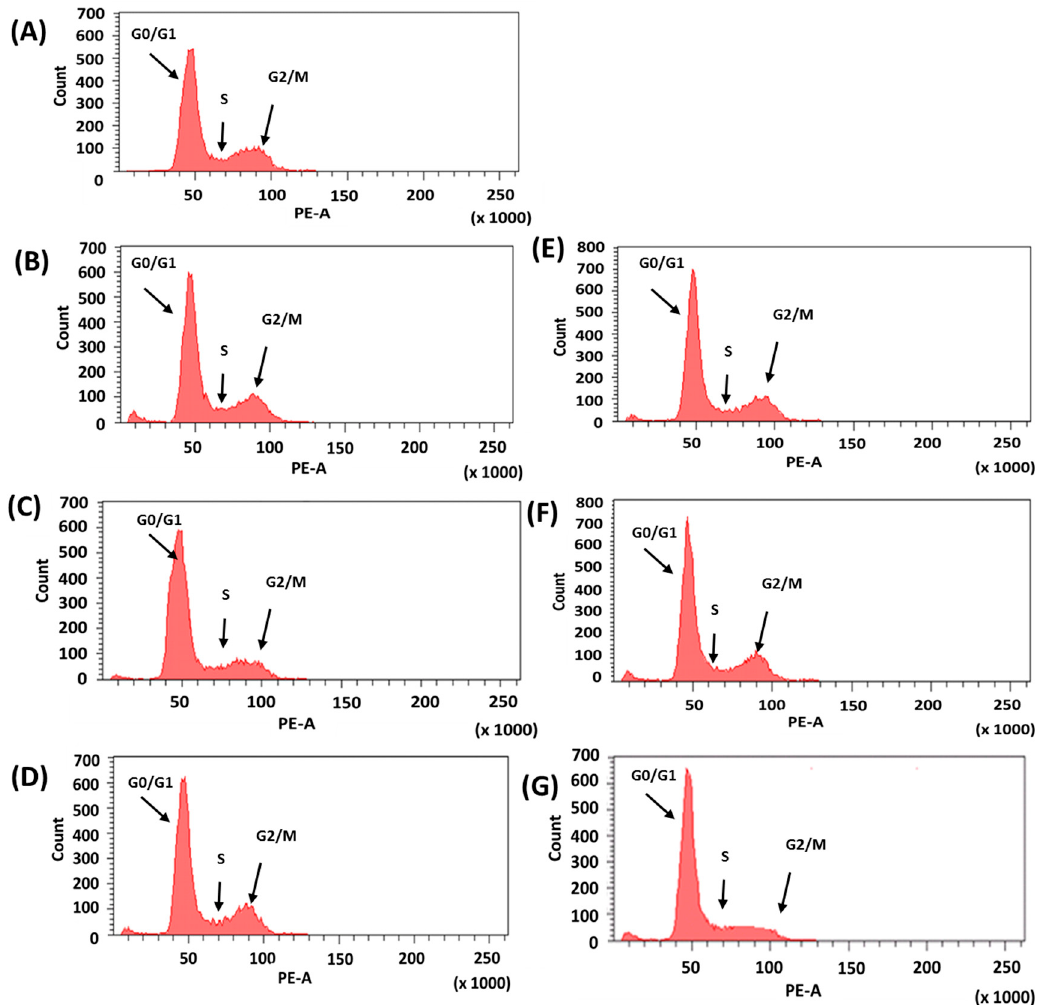
Figure 5. Cell cycle distribution analysis. ( A ) Control group; ( B ) wogonin for 24 h; ( C ) wogonin for 48 h; ( D ) wogonin for 72 h; ( E ) W-SLN for 24 h; ( F ) W-SLN for 48 h; and ( G ) W-SLN for 72 h (the concentration of wogonin was 200 µM). At the end of each time, cells were ethanol-fixed, stained with propidium iodide (PI), and analyzed in the DNA content by flow cytometry. Relative distribution of cell population in the cell cycle phase is presented.